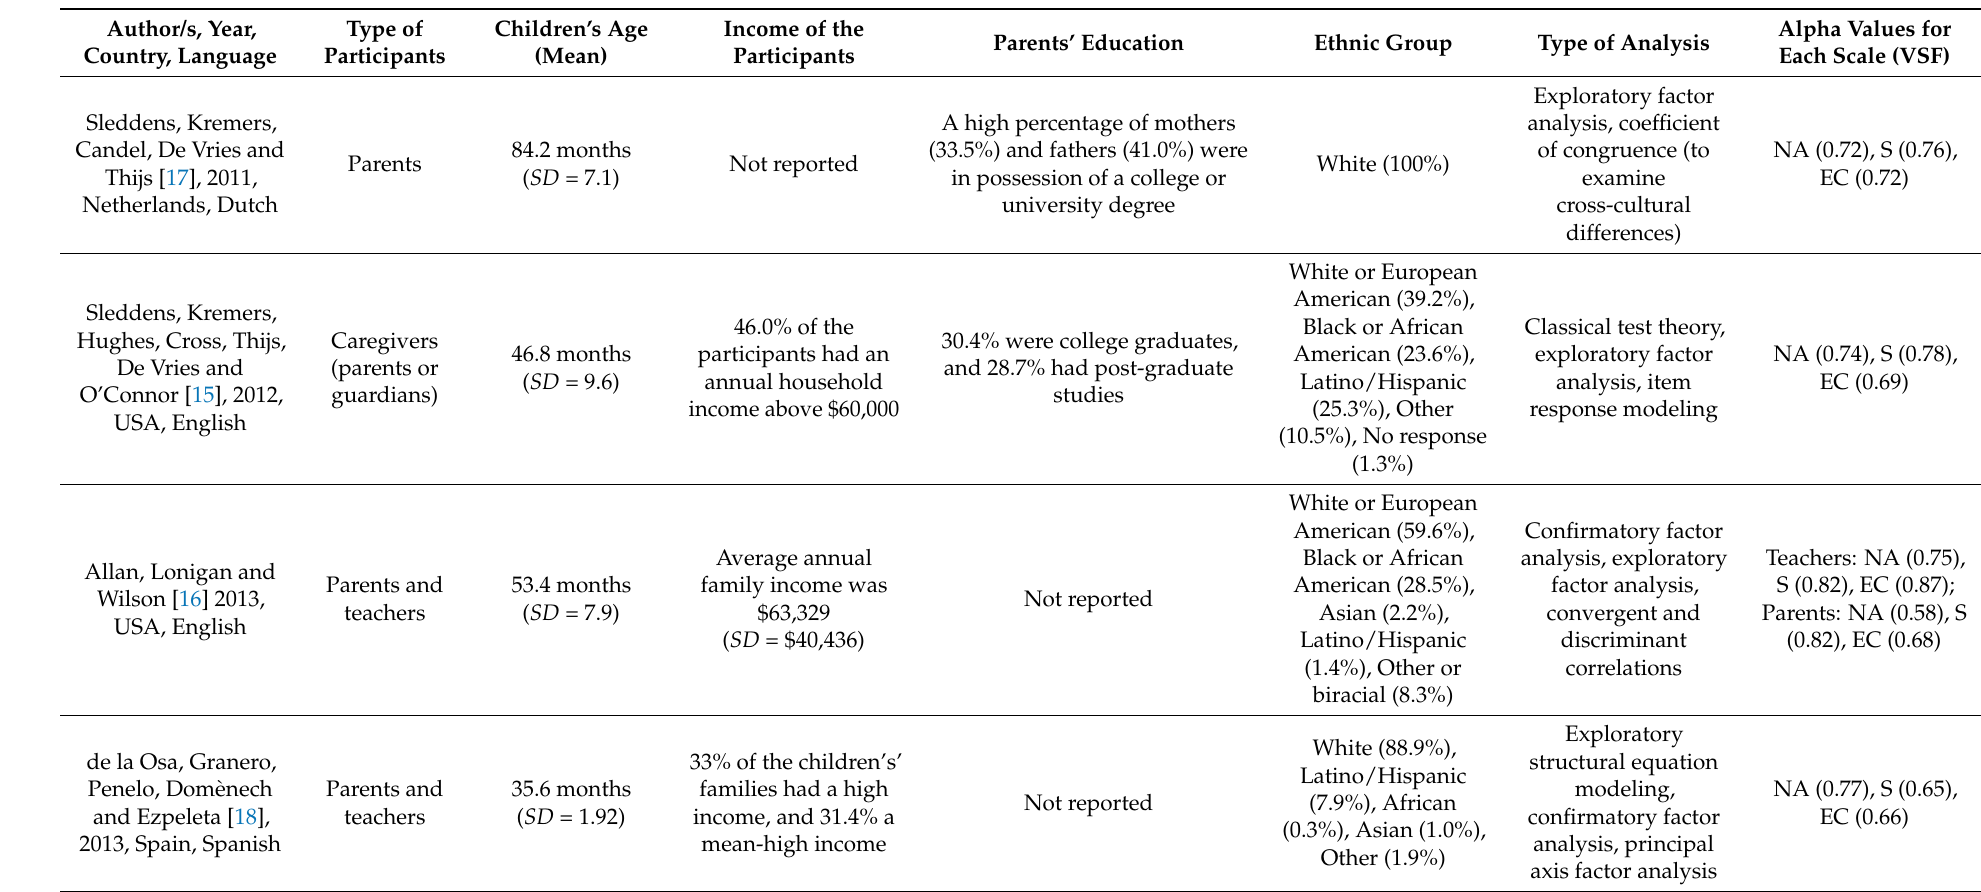
Table 1. Summary of the characteristics of studies assessing the psychometric properties of the